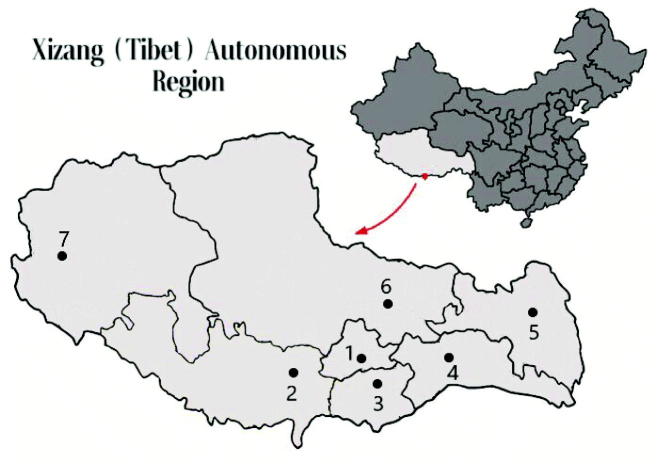
Hemodialysis centers in the Xizang (Tibet) Autonomous Region. (1) The People’s Hospital of Tibet Autonomous region and Second people's Hospital of Tibet Autonomous region (Altitude 3650 m); (2) Shigatse People’s Hospital (Altitude 4000 m); (3) Shan Nan People’s Hospital (Altitude 3700 m); (4) Lin Zhi District People’s Hospital (Altitude 3100 m); (5, 6 and 7) Districts without hemodialysis centers.